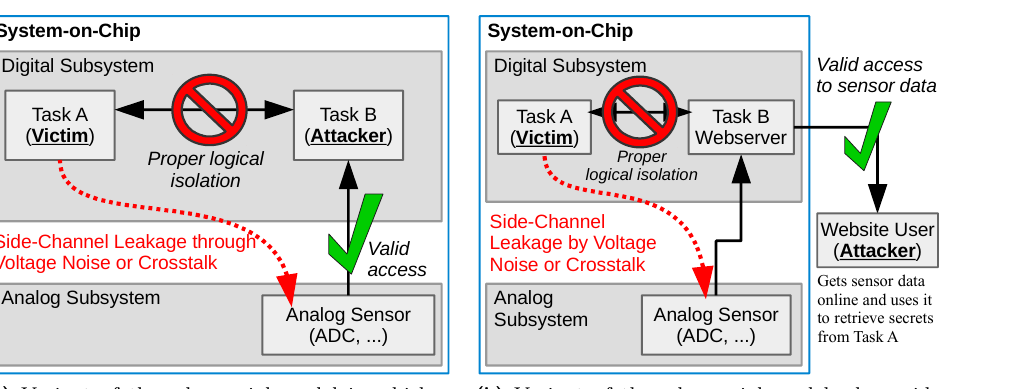
Figure 1: Basic principle of the two variants of our adversarial model considered in this paper. In both cases an ADC in the Analog Subsystem is biased from Task A in the digital subsystem. This bias can contain secret information that Task A